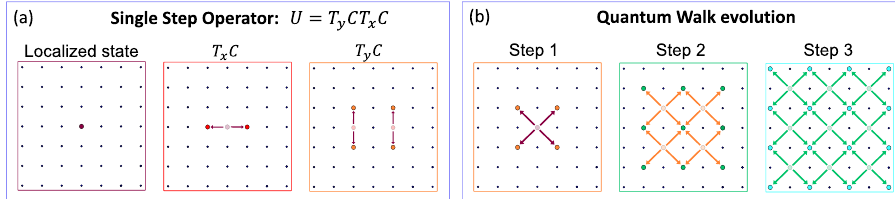
Fig. 1 Scheme of a two-dimensional quantum walk. a The single-step operator is performed via subsequent applications of a coin- dependent translation along the x axis and one along the y axis, interspersed with a coin rotation. b The full quantum walk evolution is then obtained via the multiple sequential application of the single-step operator U .